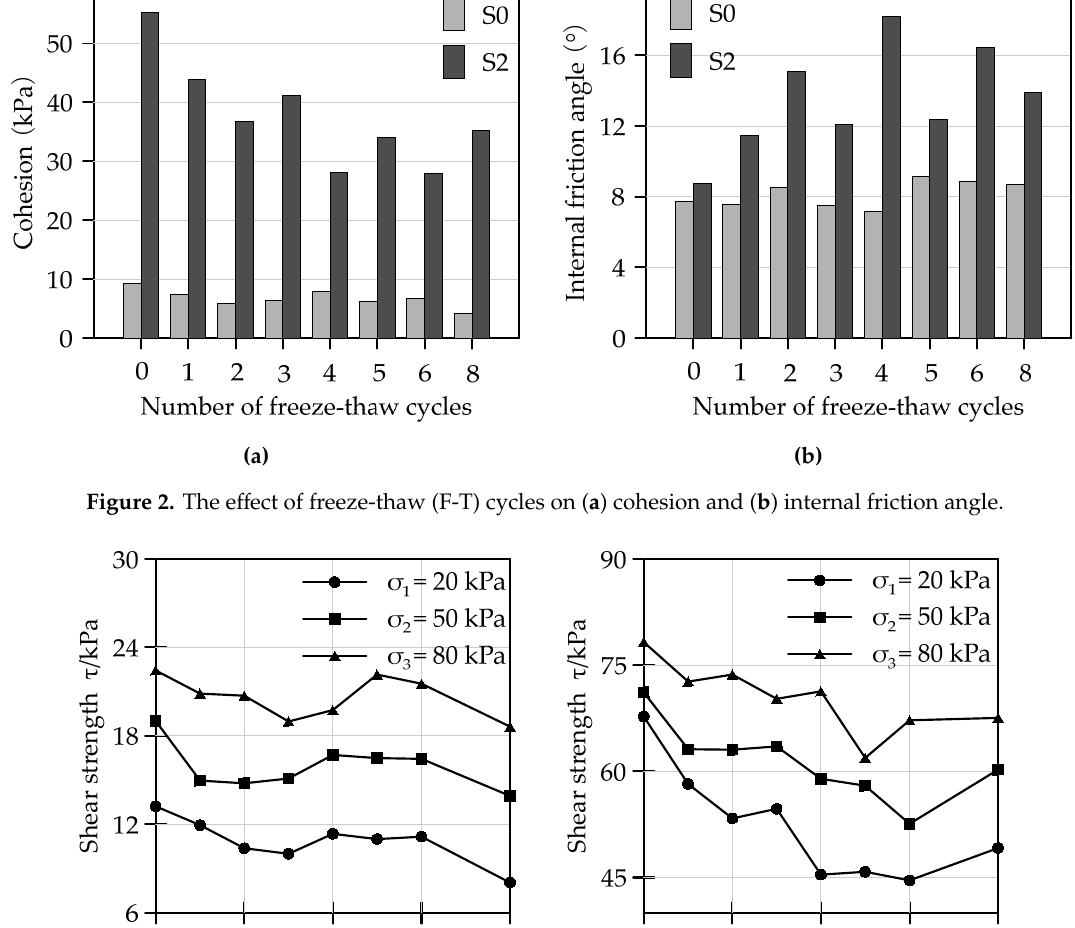
Figure 2. The effect of freeze-thaw (F-T) cycles on (a) cohesion and (b) internal friction angle.